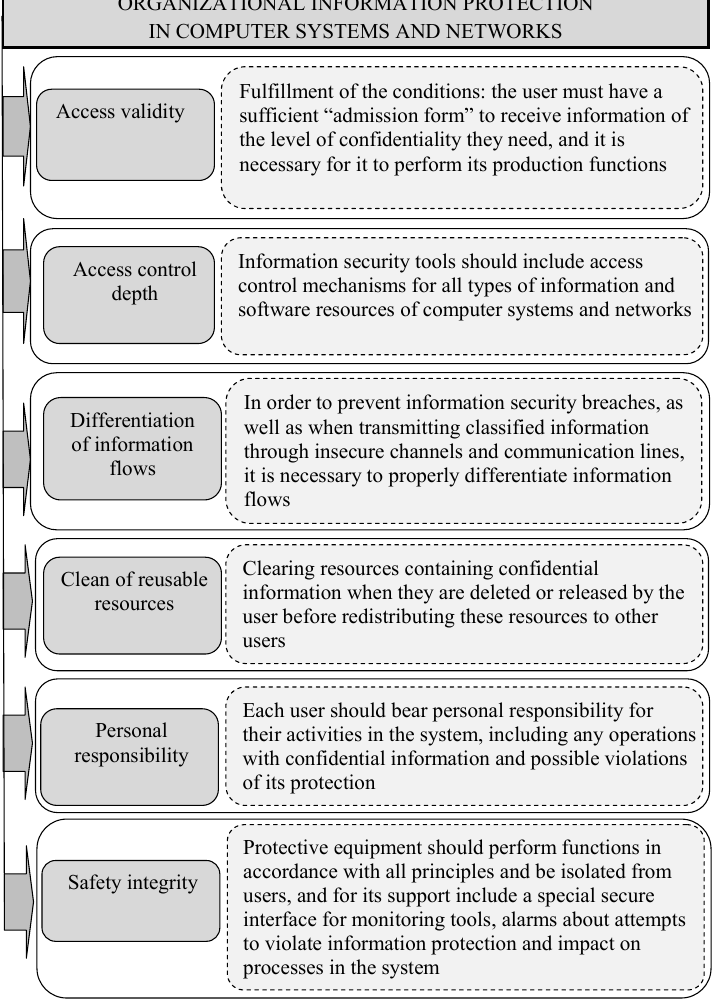
Fig. 1. The principles of an integrated approach to information